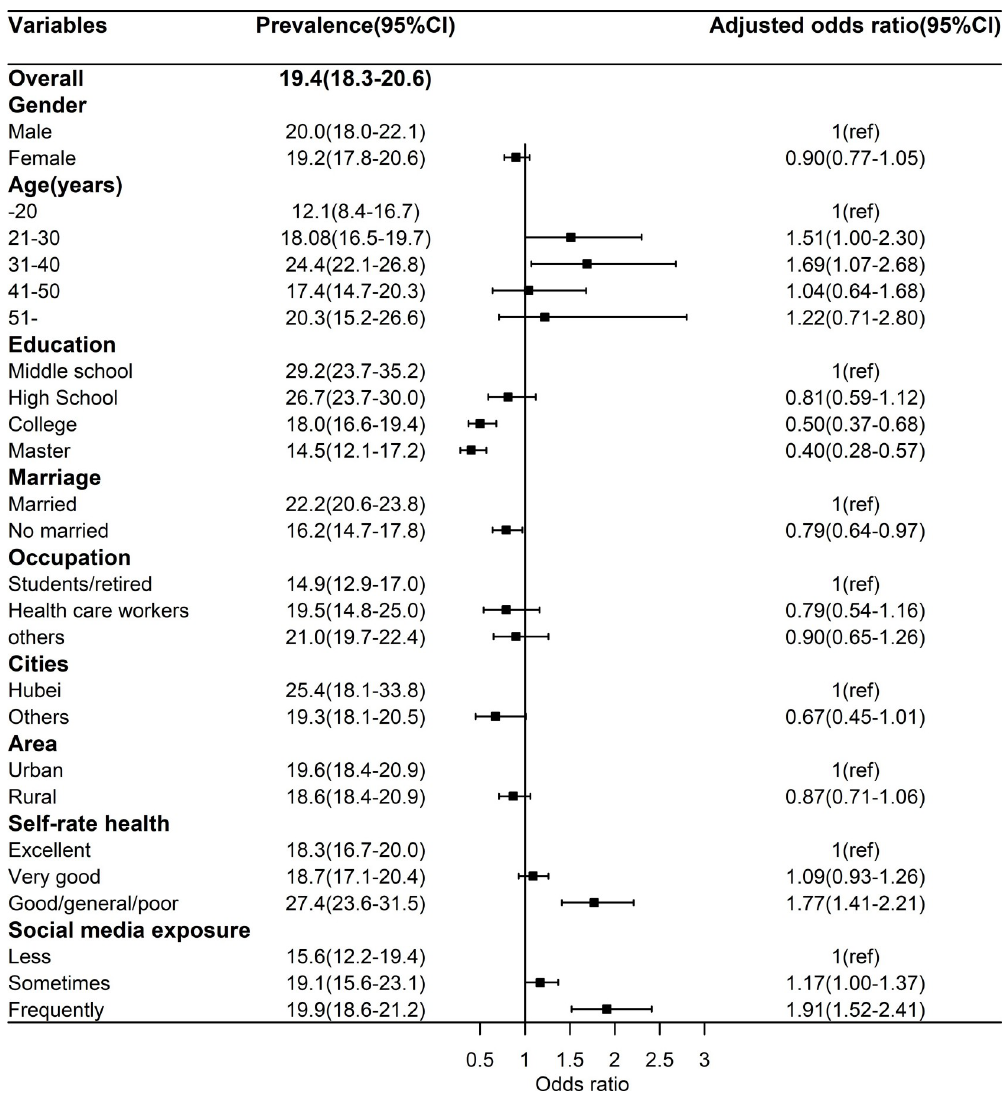
Fig 3. Prevalence of combination of depression and anxiety and relevant